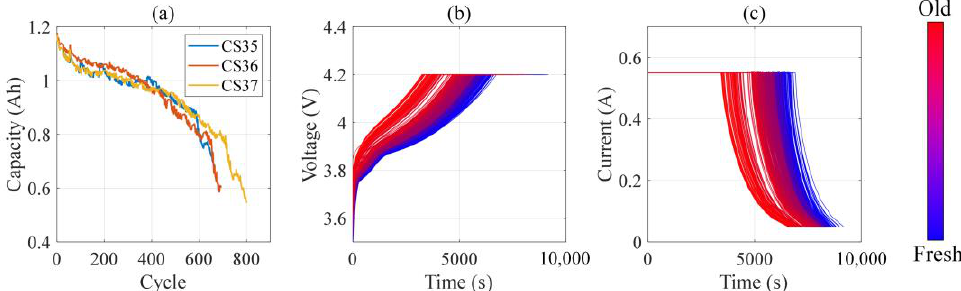
Figure 3. Details of the CALCE dataset: ( a ) capacity degradation curves; ( b ) voltage curves of CS35; ( c ) current curves of CS35.